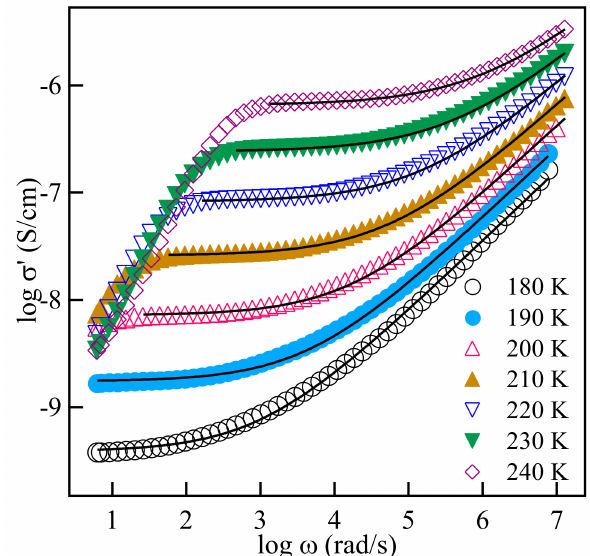
Figure 4. The conductivity spectra of LLN-Sm40 garnets at different temperatures. The solid curves between the points represent the fitting based on Equation